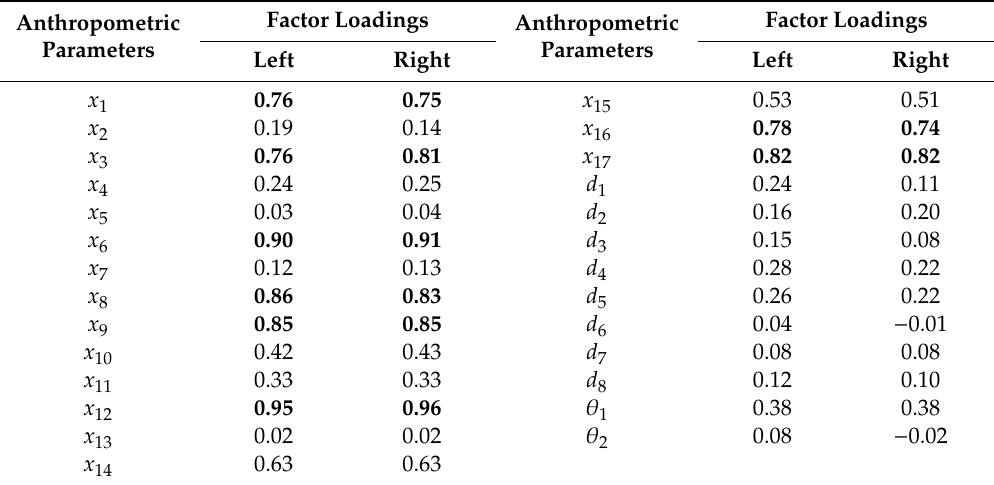
Figure 4. Variance explained by the 16 common factors in the factor analysis. Table 2. The selection of anthropometric